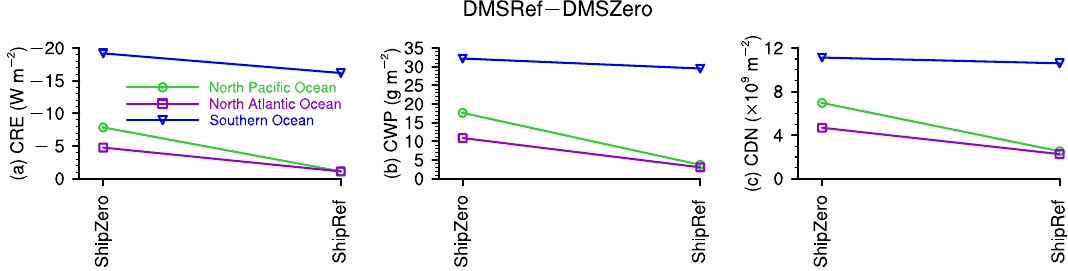
Figure 10. Impacts of ISE on cloud responses to DMS emissions. (a) Cloud radiative effects at the TOA (Wm − 2 ), (b) column-integrated cloud water path (gm − 2 ), and (c) column-integrated cloud droplet number ( × 10 9 m − 2 ). The green, purple, and blue curves respectively represent quantities area-averaged over the North Pacific Ocean (NPO), the North Atlantic Ocean (NAO), and the Southern Ocean (SO), which are shown as red boxes in Fig. 1a. These results are from MARC